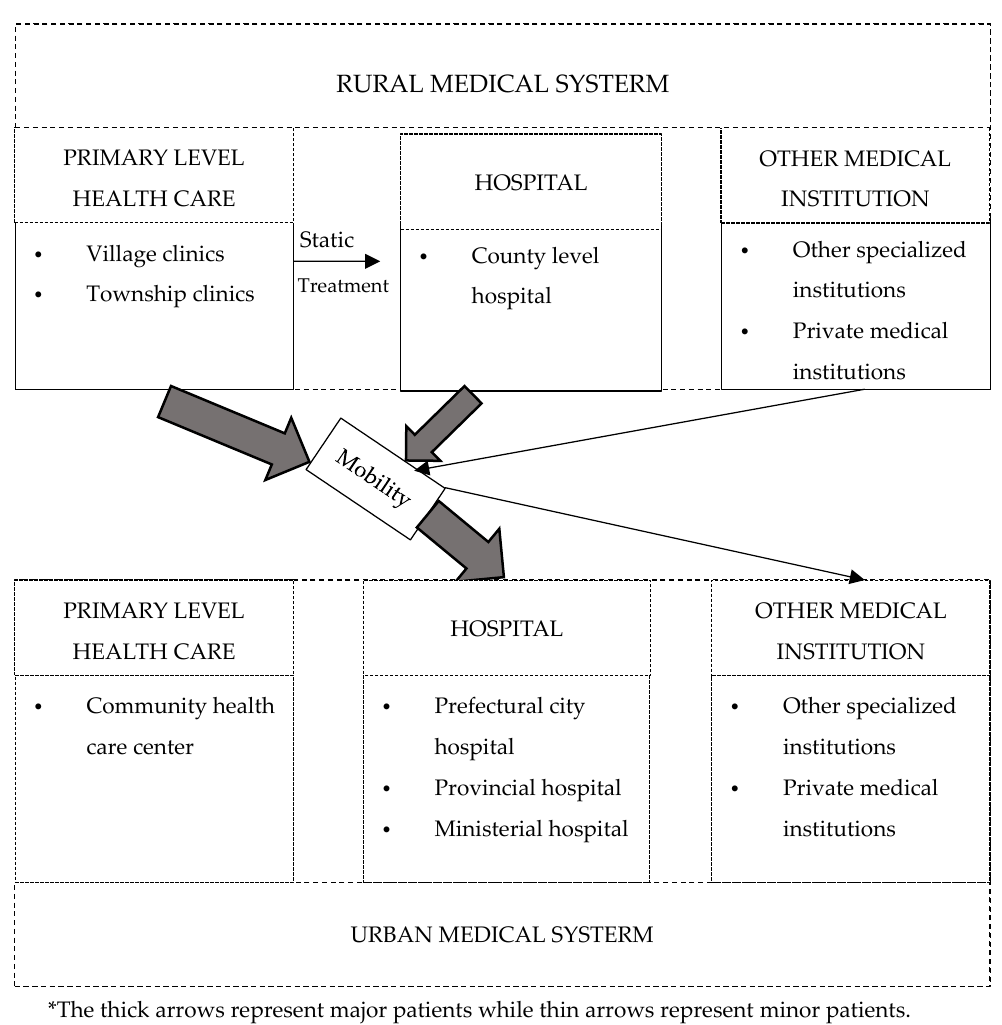
*The thick arrows represent major patients while thin arrows represent minor patients. Figure 1. Medical systems in China. Figure 1. Medical systems in